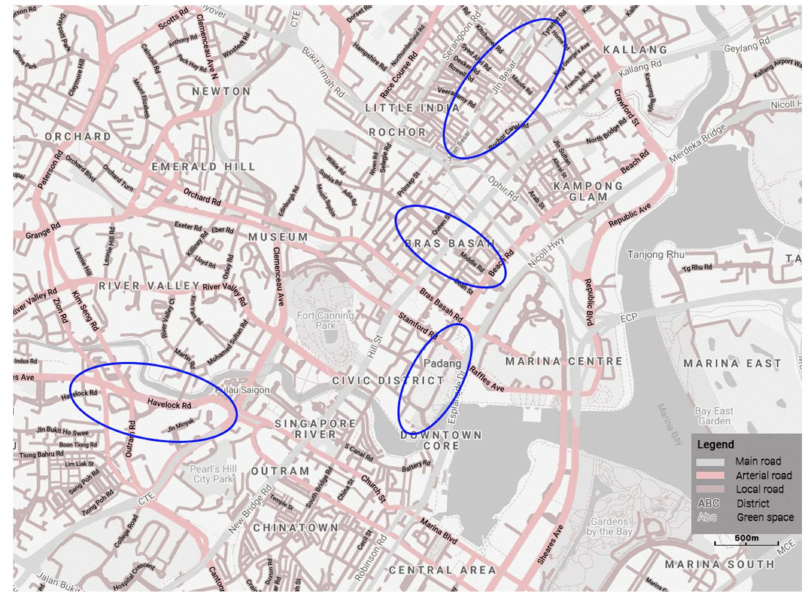
Figure 1. Singapore town centre with the locations of the toponyms investigated (adapted from google.com /